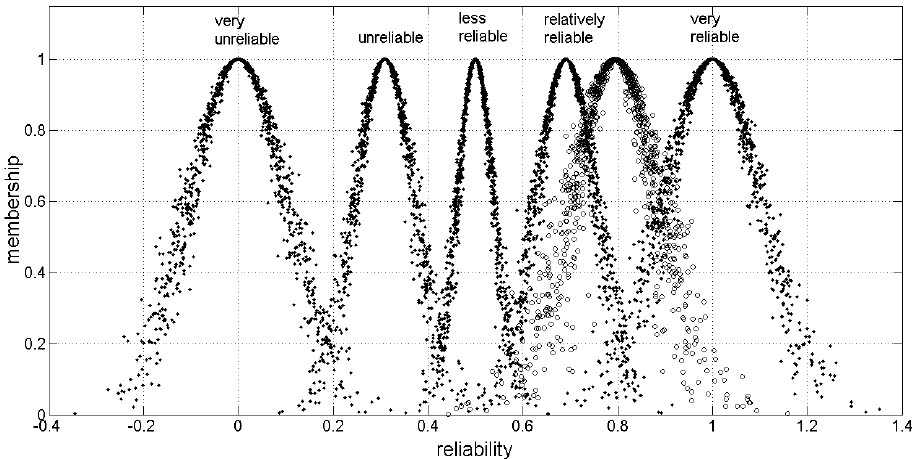
Figure 6. Member fuzzy set map for reliability evaluation of the US air traffic network.